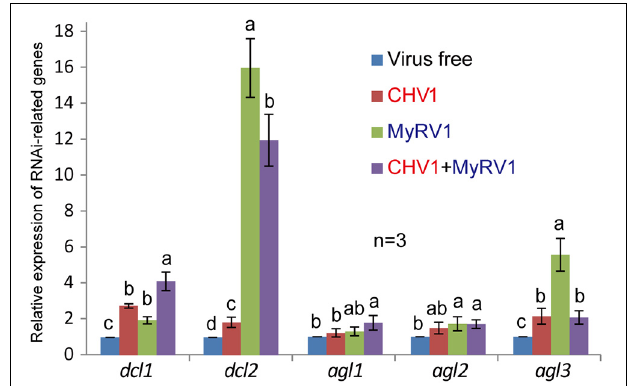
FIGURE 5 | The relative transcript expression of RNA silencing-related genes in V. mali strains singly or doubly infected with CHV1 and MyRV1. The transcript expression of V. mali dcl1 , dcl2 , agl1 , agl2, and agl3 genes following single and double virus infection were analyzed by quantitative RT-PCR. The data are the means ± SD ( n = 3). The different letters indicate a significant difference at p < 0.01 (one-way